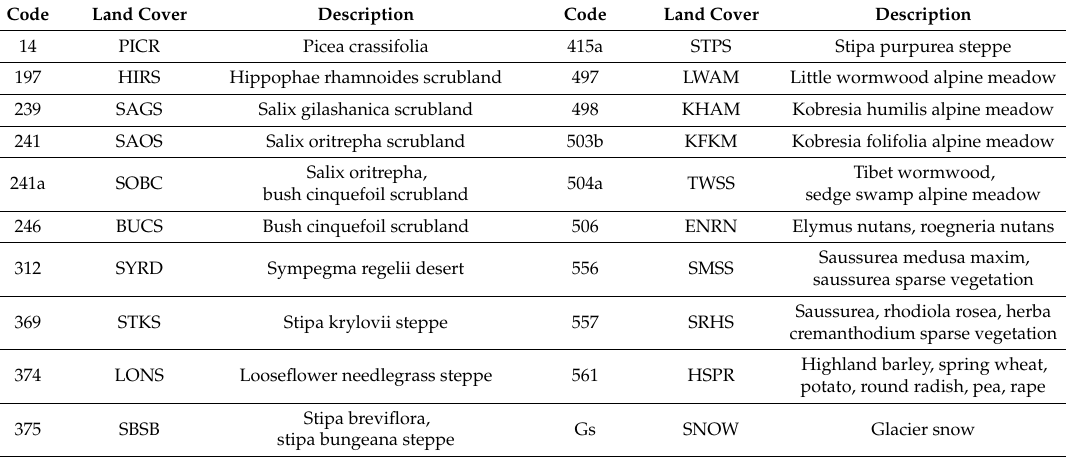
Table 2. Code list of land cover types.